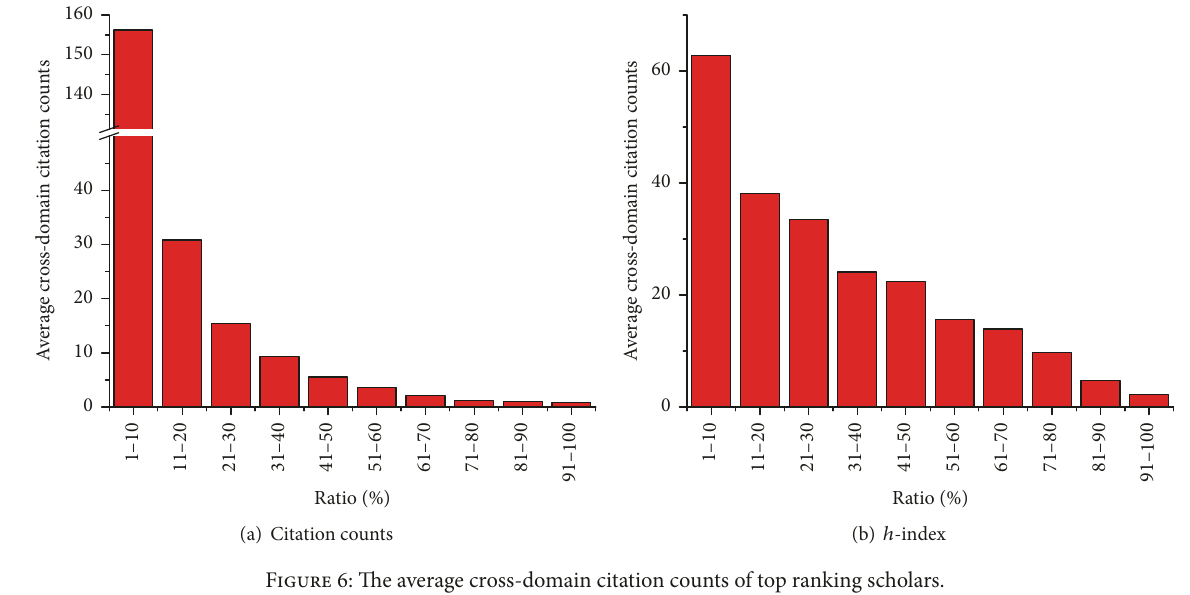
Figure 6: The average cross-domain citation counts of top ranking scholars.